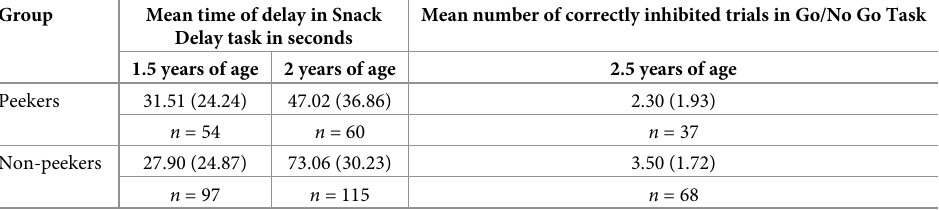
Table 3. Descriptive statistics of inhibitory control tasks (SD in parentheses) in the Groups of peekers and non- peekers. Group